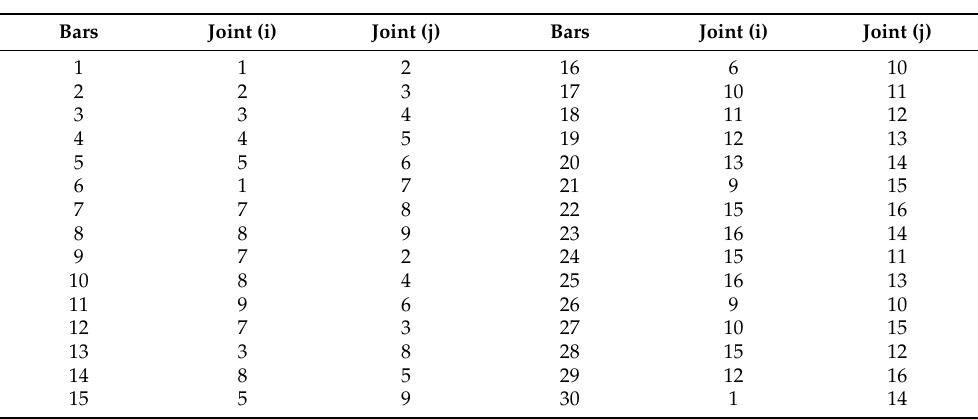
Table 4. Number and position of